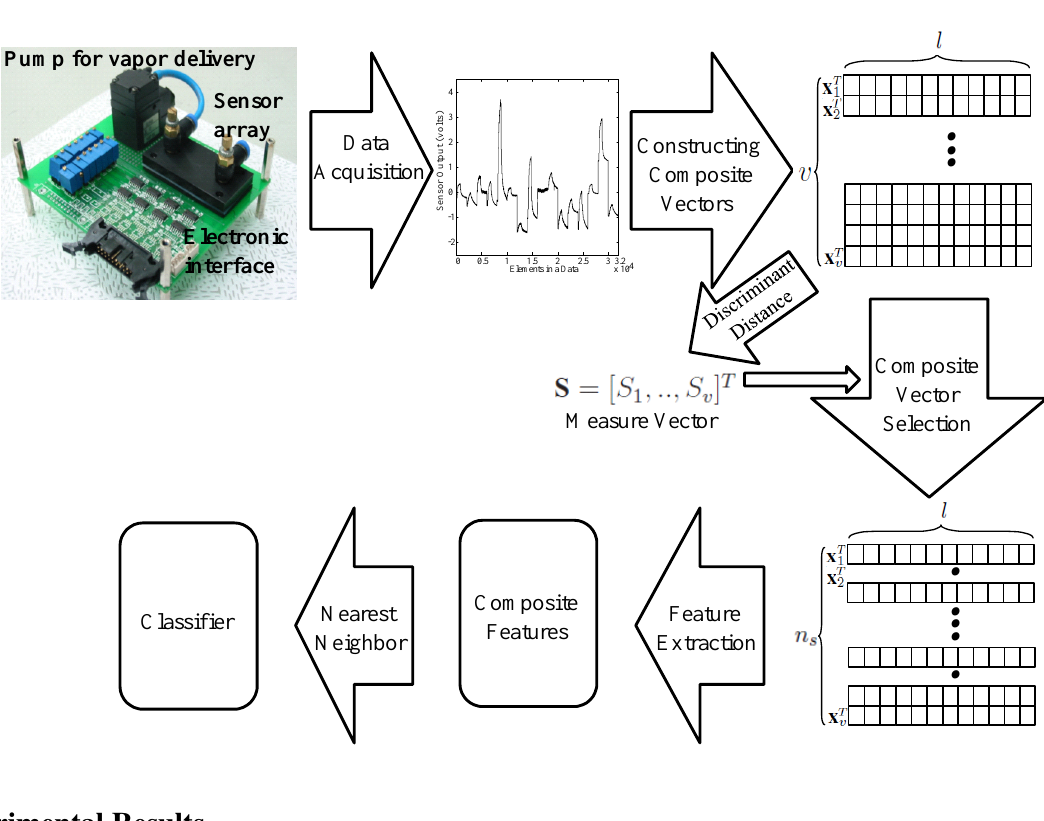
Figure 4. Overall procedure of the proposed electronic nose